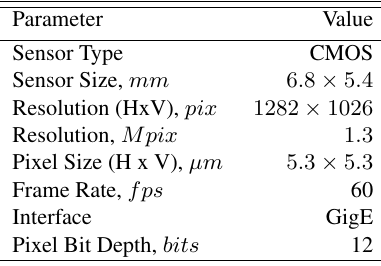
Table 1. Main characteristics of Basler acA1280-60gm GigE